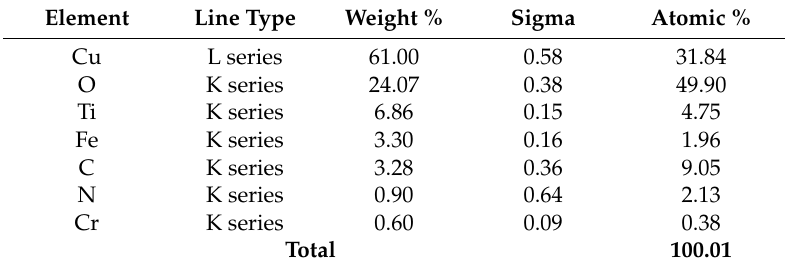
Figure 8. Electron micrograph at 5000x magnification (A) and EDX spectrum of the crystalline deposit (B) for the titanium nitride cathode after Ageing Protocol B. Table 3. Quantitative analysis of the above EDX spectrum for the crystalline deposit.